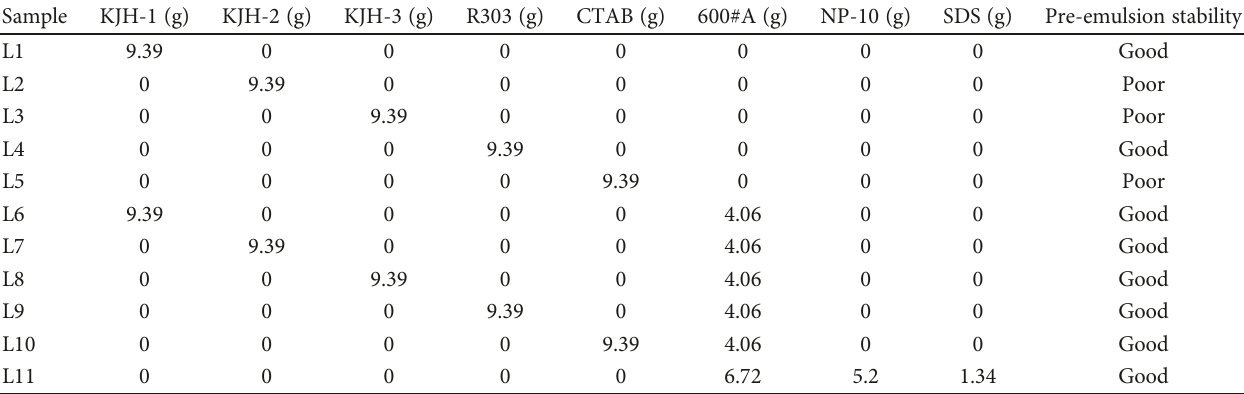
Table 1: Recipes for the pre-emulsion